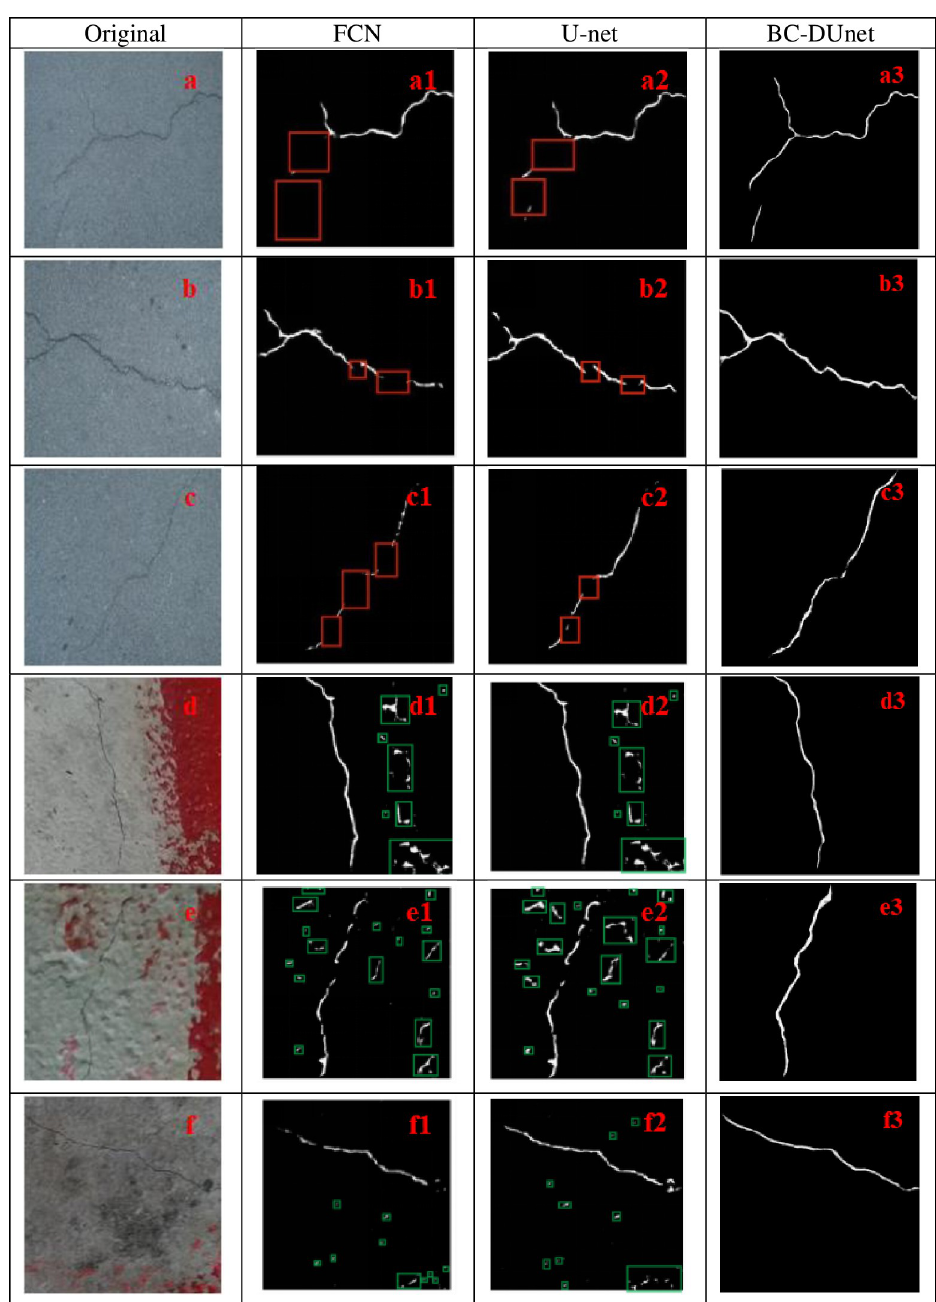
Fig 8. Comparison diagram of segmentation and segmentation effects pictures by FCN, U-Net, and BC-DUnet (Prop.) methods.